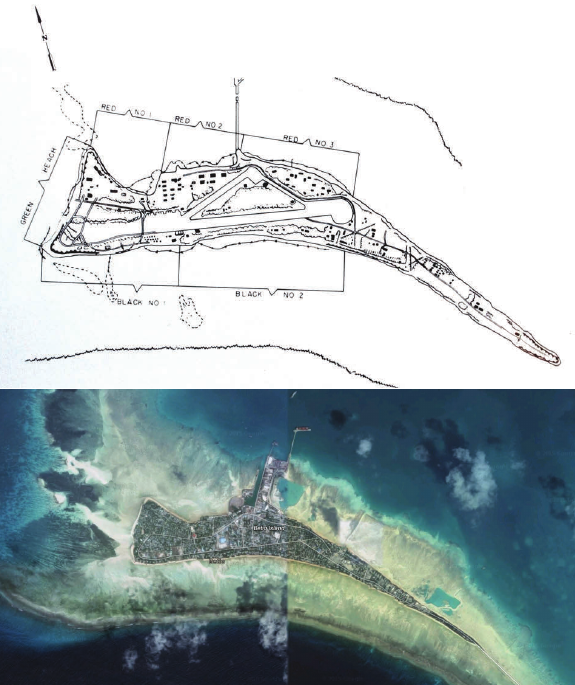
Fig. 10: Top is a US intelligence map of the Betio Island in 1943 (from [16]) and bottom is a latest satellite image (from [17]). Despite the sharply sea level rises of the BoM narrative, the island is longer and fatter, and it is filled up with peoples, homes and